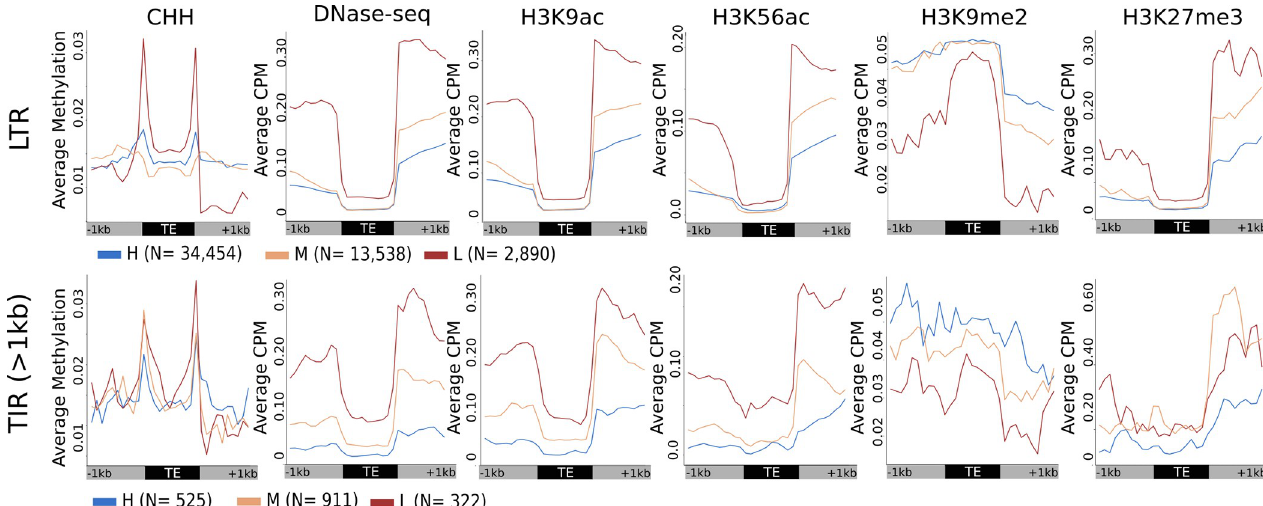
Fig 5. Analysis of chromatin within and surrounding the three clusters of TEs defined based on flanking levels of CG and CHG methylation. The relative abundance of CHH methylation, chromatin accessibility (DNase-seq and histone modifications H3K9ac, H3K56ac, H3K9me2 and H3K27me3 were determined within and flanking TEs that were classified as having high, moderate or low flanking methylation patterns. The CHH methylation was determined for 100bp tiles and the average level within the H, M and L categories was calculated. For the remaining chromatin marks (ChIP and DNase), the average CPM for each 100bp bin within the categories H, M and L was calculated. The top set of plots show the metaprofiles for LTR elements (N = 50,882) in the three clusters with high (blue), moderate (orange) and low (red) indicated with different colors. The lower set of plots show the metaprofiles for the three clusters of TIR elements (N = 1,758) only using elements > 1kb in length. Number of elements in each group indicated next to key.